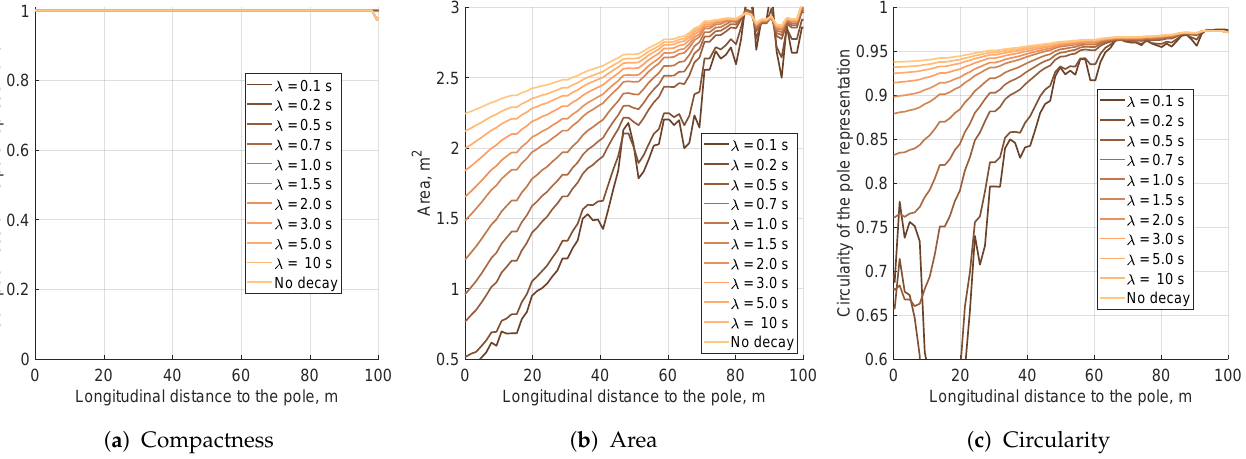
Figure 14. The key performance indicators computed for the different values of decay mean lifetime for the pole moved by 10 m